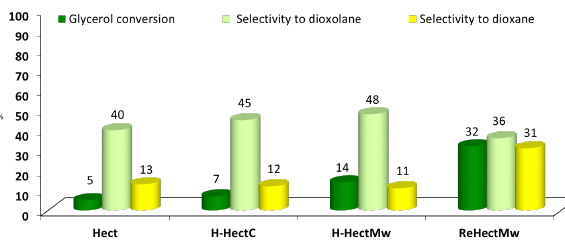
Figure 4: Catalytic activity results of the hectorite